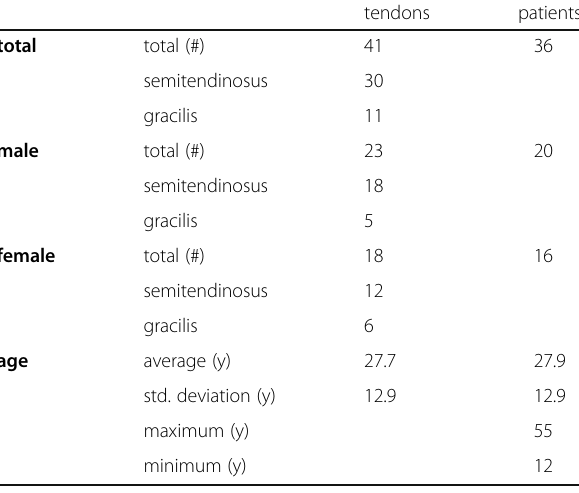
Table 1 Demographics and origin of tissue fragments